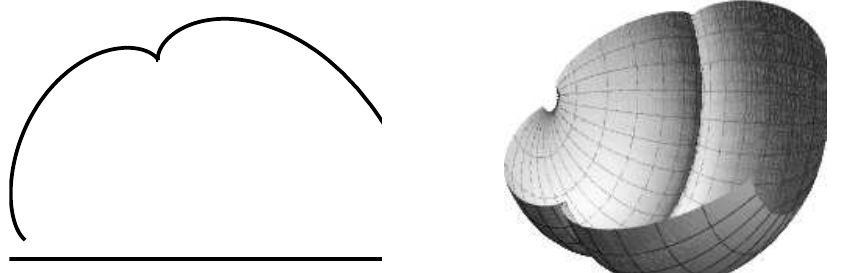
Figure 1 - The generating curve left and the surface of revolution of Example 2.4. The horizontal line is the axis of rotation.